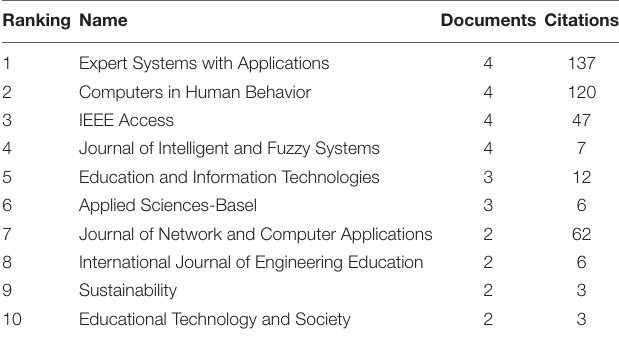
TABLE 2 | The top 10 productive journals from 2010 to 2021 (Documents ≥